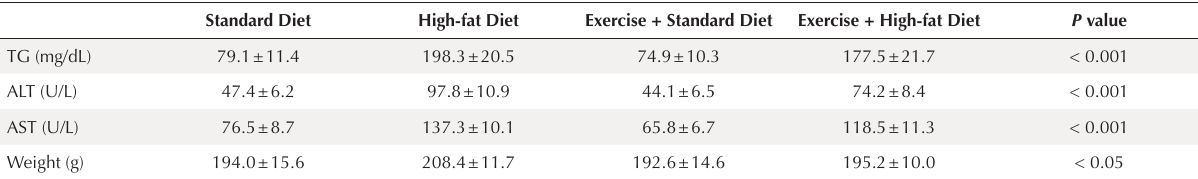
Table 1. Mean ± SD of variables between groups Standard Diet High-fat Diet Exercise + Standard Diet Exercise + High-fat